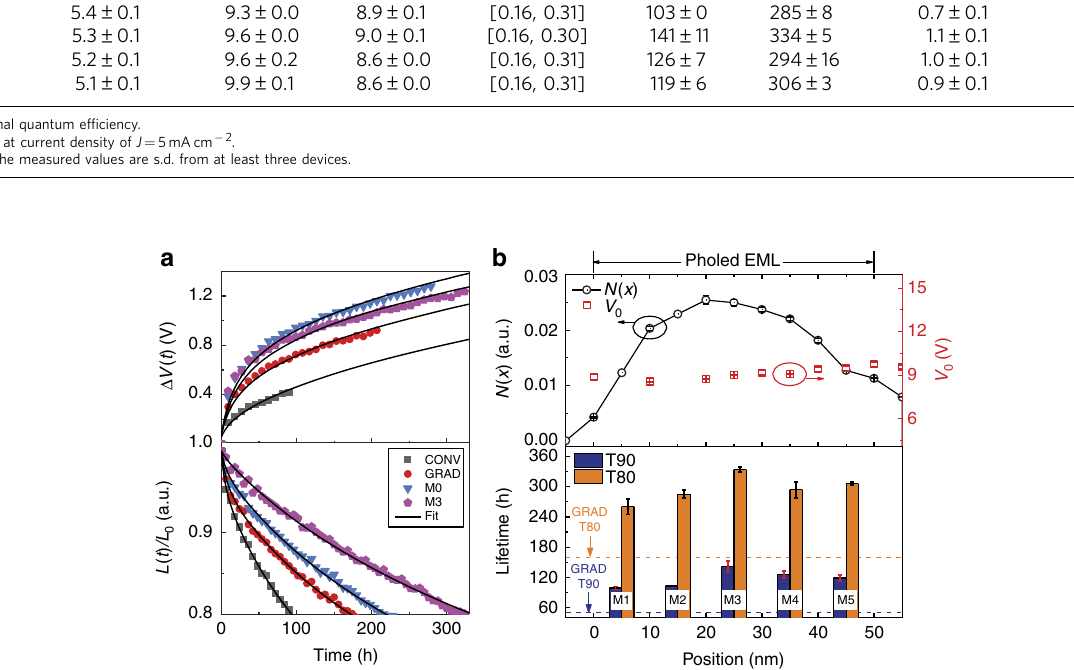
Figure 4 | Lifetime and modelling of the PHOLEDs. ( a ) Lifetime characteristics of CONV, GRAD, managed PHOLEDs M0 and M3. Top and bottom show the time evolution of the operating voltage change, D V ( t ) ¼ V ( t )– V 0 , and the normalized luminance degradation, L ( t )/ L 0 , respectively. Solid lines are fits based on the model in Methods (see fitting parameters in Table 2). ( b ) (Top) Exciton density profile, N ( x ), of the PHOLED emission layer (EML) as a function of position, x , and operating voltages of the devices using delta-doped sensing layer at J ¼ 5mAcm (cid:2) 2 (Supplementary Note 3). The origin of the x -axis is at the HTL/EML interface. The operating current density results in a luminance of L 0 ¼ 1,000cdm (cid:2) 2 . (Bottom) Lifetimes (T90 and T80) of managed devices (M1–M5) as functions of the position of the managed EML zones. T90 and T80 of the managed devices are compared with those of the GRAD (dotted lines). Note that the variation in lifetime qualitatively follows the exciton density profile, suggesting that placing the manager at the point of highest exciton density results in the longest device lifetime. Error bars represent 1 s.d. for at least three